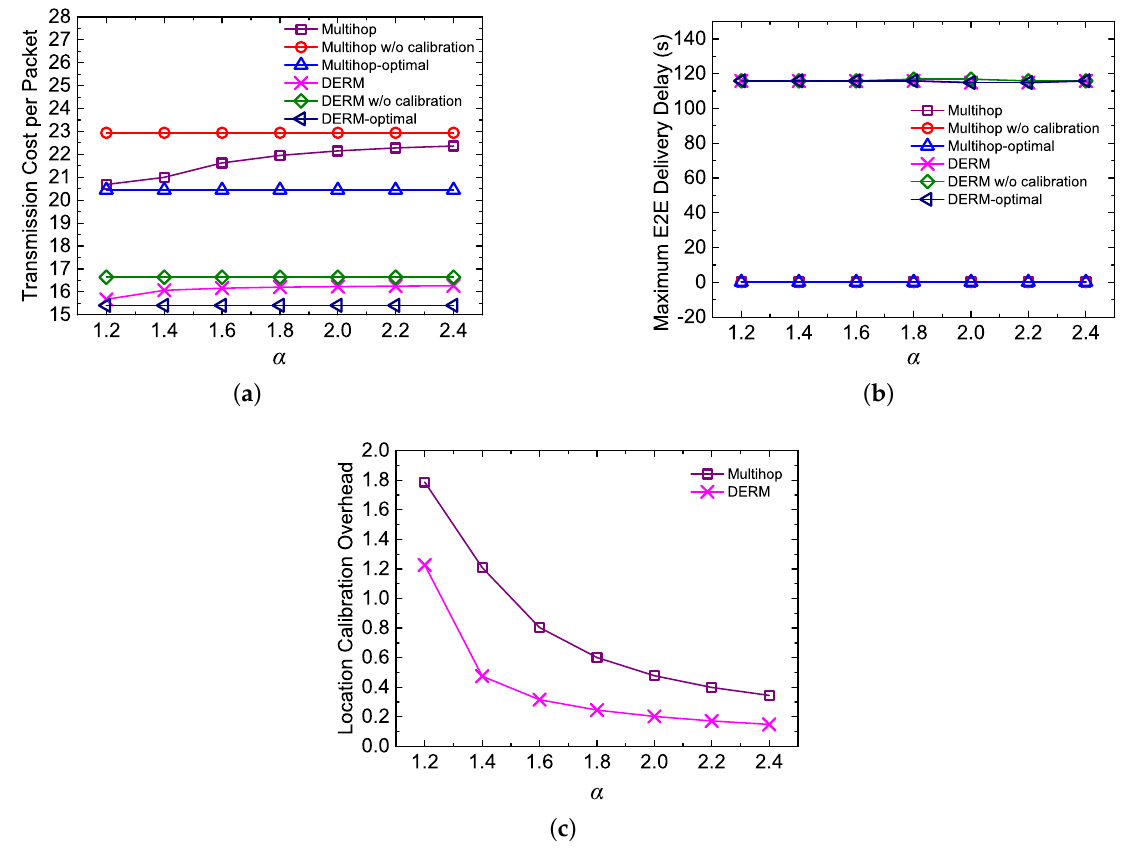
Figure 11. Impact of α ( v M = 2 m/s, D s = 120 s, and the pause time is 30 s). ( a ) transmission cost per packet; ( b ) maximum end-to-end delivery delay; ( c ) location calibration